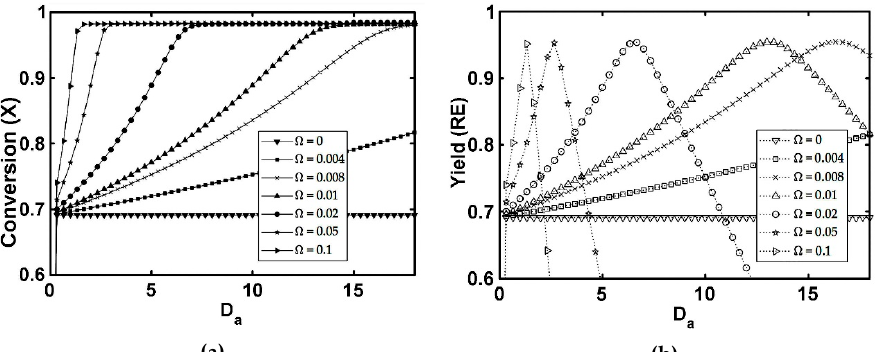
Figure 7. Conversion and ester yield profiles in a IFBPVMR ( Configuration 3 ) as a function of: ( a ) the D a dimensionless number and ( b ) the Ω dimensionless number.